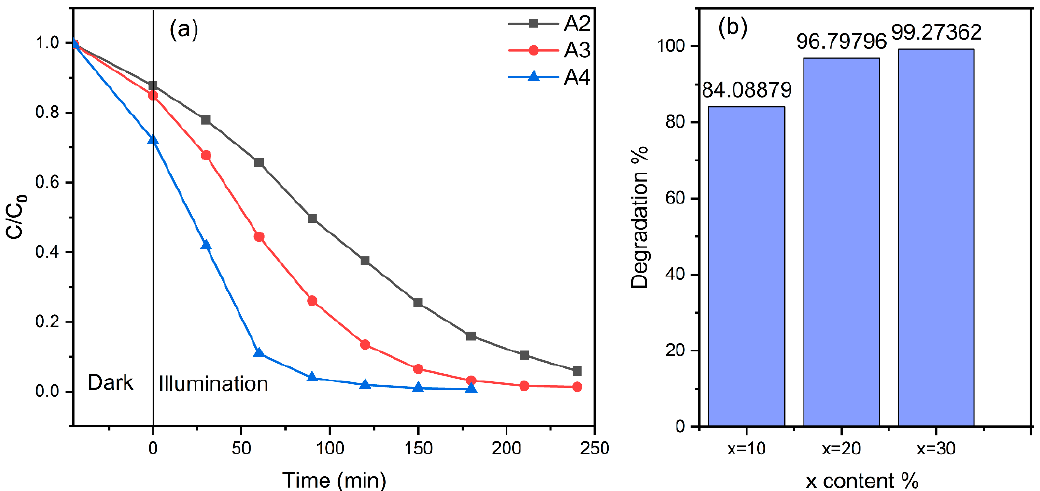
Figure 5. Degradation efficiencies of prepared glasses: ( a ) plot of C/C 0 versus time t and ( b ) percent- age of MB degraded after 180 min.